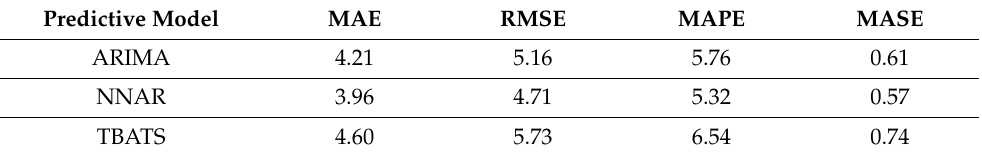
Table 2. Accuracy measures for the out-of-sample (test-set) forecasting performance. Predictive Model MAE RMSE MAPE MASE ARIMA 4.21 NNAR